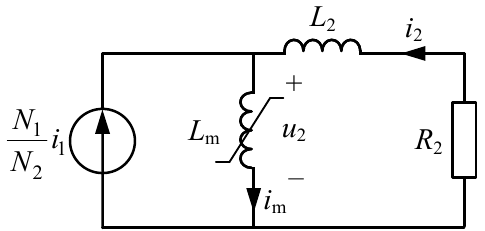
Figure 1. Simplified CT model.